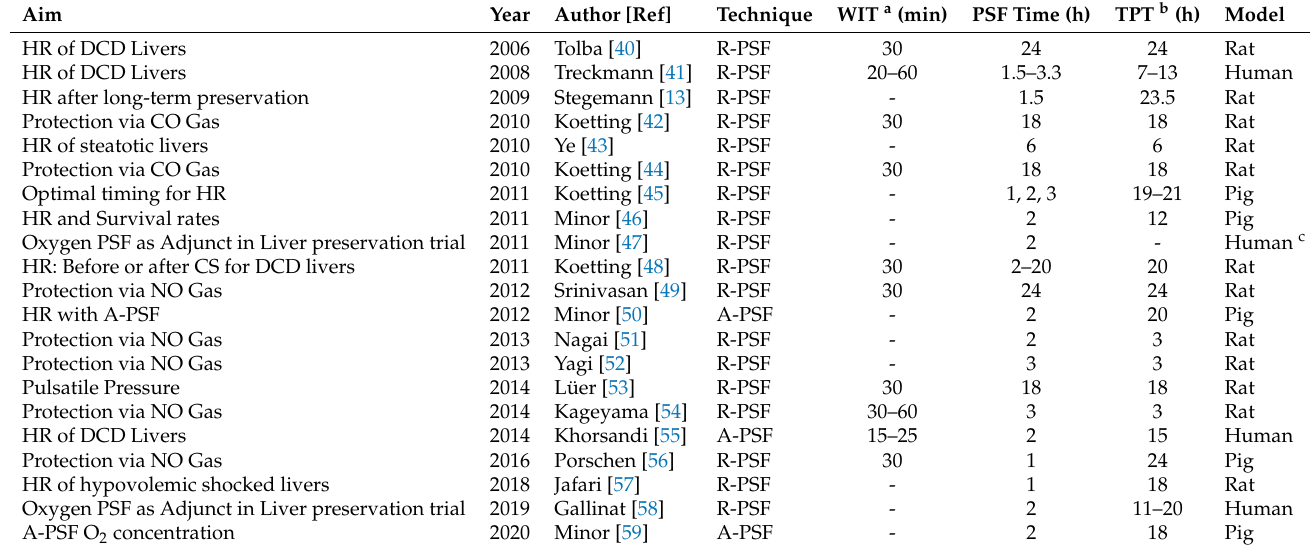
Table 1. Recent Persufflation work on the